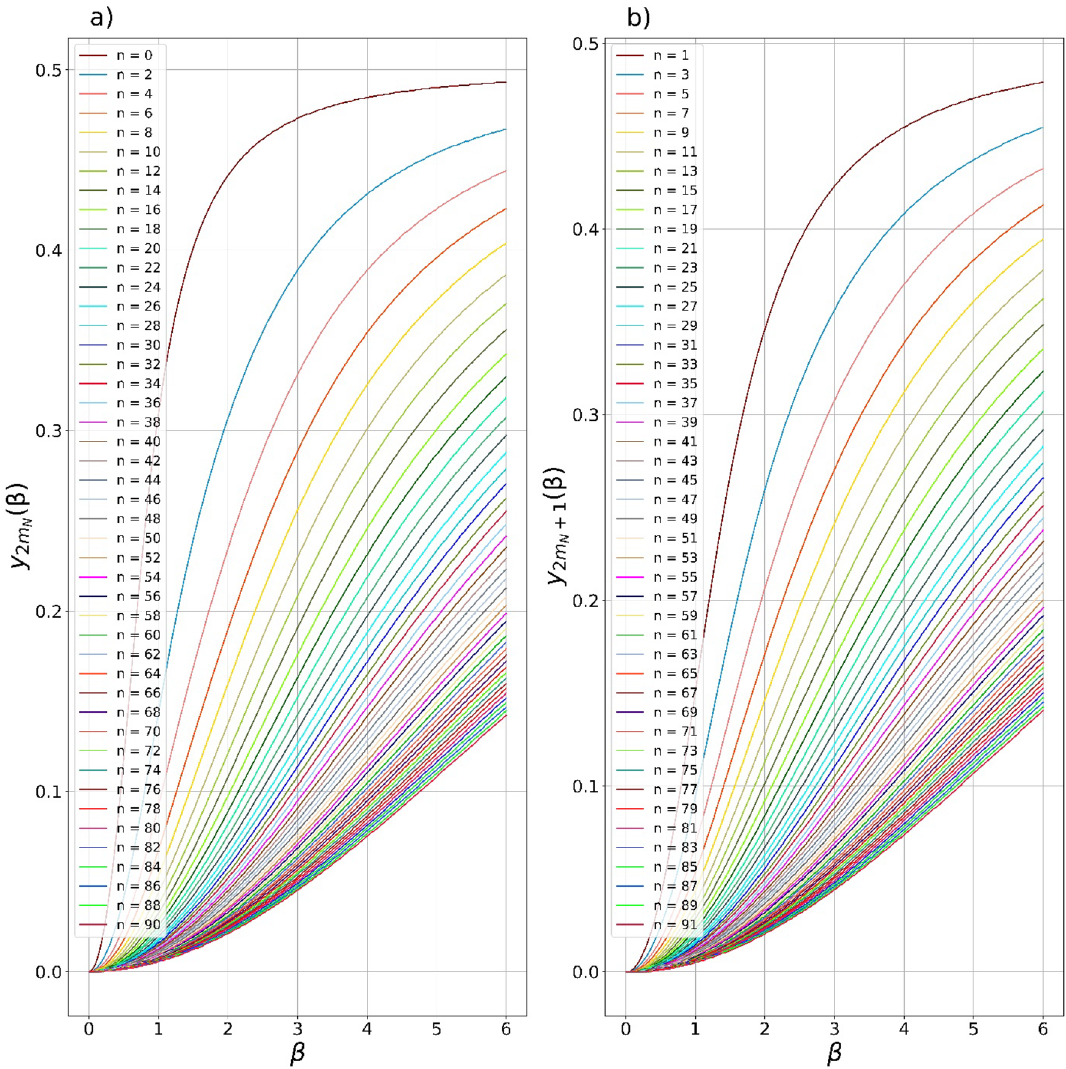
0.5 . 1 y k heralded states in Eqs. (25, 26) depend solely on one CV parameter 0 ≤ ≤ + − (β) and ( b ) y 2 m (β) that provide the N N + 1 (β) or y k (β) . The larger the number n of the extracted photons, y 2 m y 2 m N N + 1 = = (β) and y 2 m (β) , moreover accompanied by an increase in the N N + 1